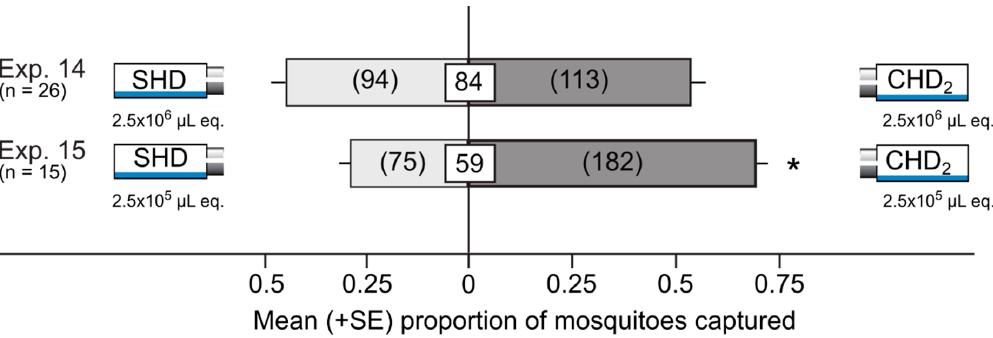
Figure 5. Mean proportion (+SE) of female yellow fever mosquitoes, Aedes aegypti , captured in Experiments 14–15 in paired traps that were baited with the SHD (a synthetic blend of sterile honeydew-derived odorants prepared according to literature data [32], Table 2) or the CHD 2 (a synthetic blend of crude honeydew-derived odorants prepared according to literature data [32], Table 2). Numbers in parentheses represent the total number of mosquitoes selecting a test stimulus, and numbers within white squares indicate the mean percentage of mosquitoes not captured. An asterisk (*) indicates a significant preference for a test stimulus ( p < 0.05; binary logistic